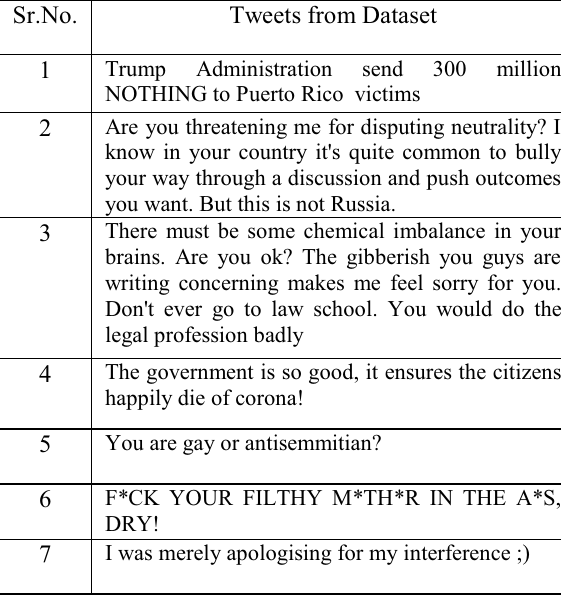
Table 1. Tweets selected to test CNN model.